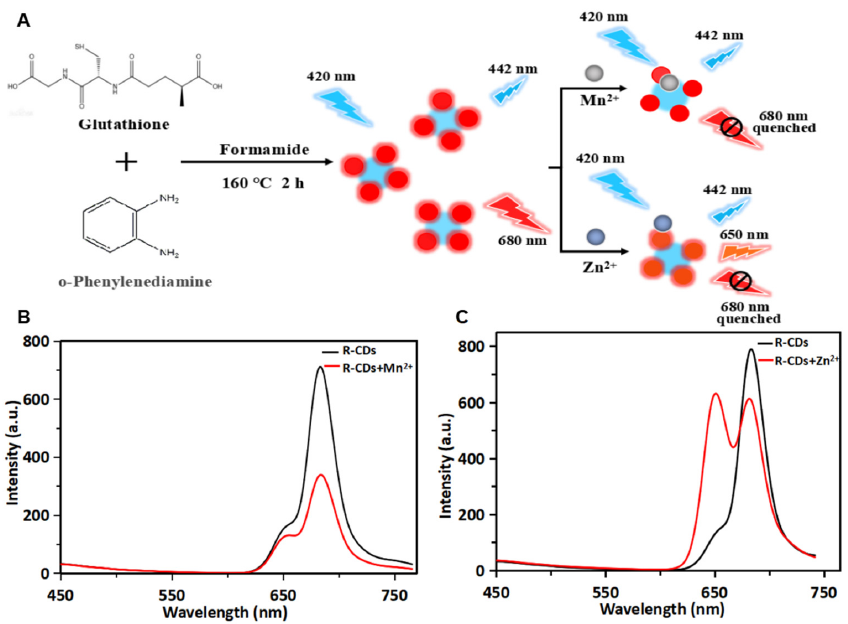
Figure 4. Schematic illustration of the preparation of R ‐ CDs and the application in the detection of Mn 2+ and Zn 2+ ( A ). Fluorescence spectra of R ‐ CDs (black curve) and R ‐ CDs+Mn 2+ (red curve) ( B ). Mn 2+ and Zn 2+ ( A ). Fluorescence spectra of R-CDs (black curve) and R-CDs+Mn 2+ (red curve) ( B ). Fluorescence spectra of R ‐ CDs (black curve) and R ‐ CDs+Zn 2+ (red curve) ( C ). Fluorescence spectra of R-CDs (black curve) and R-CDs+Zn 2+ (red curve) ( C